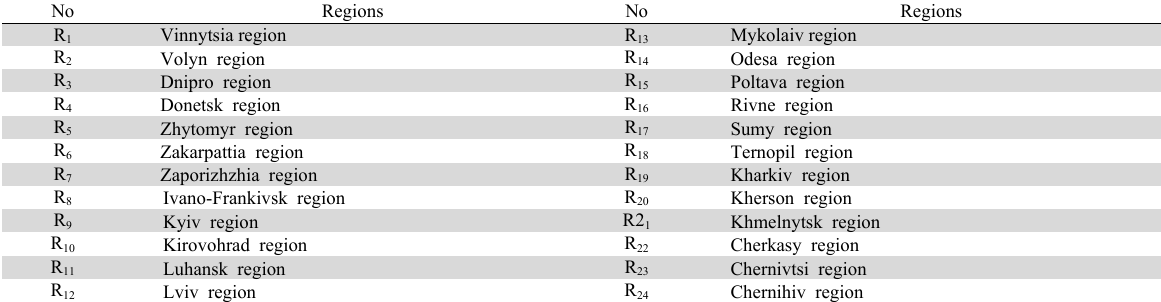
Table 1 Objects for comparative analyses of road infrastructure indicators